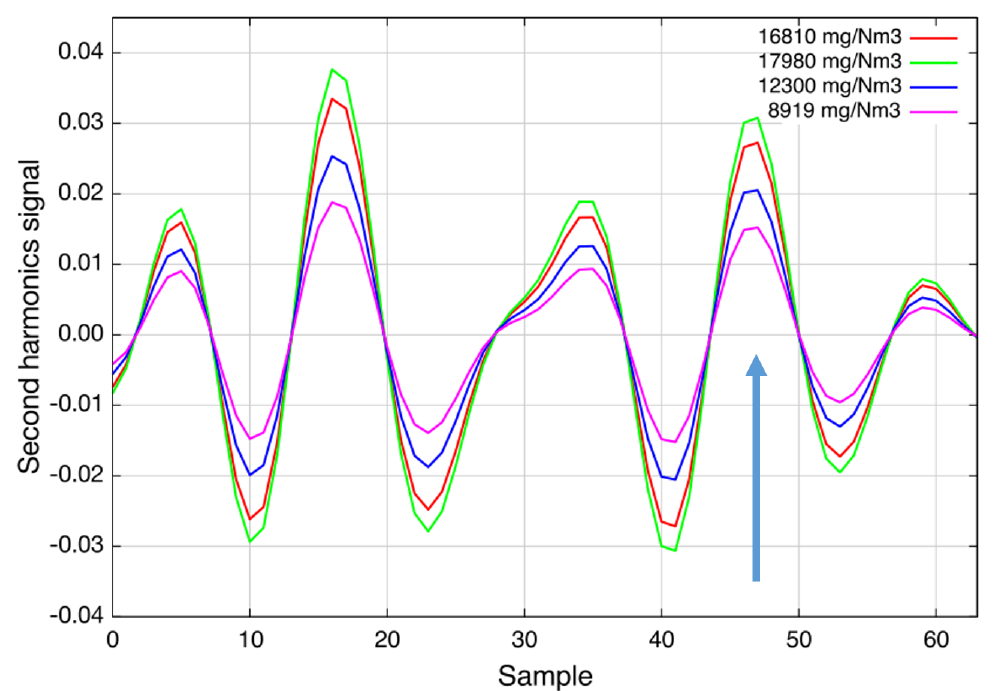
Figure 6. Second harmonic spectra of sulfur dioxide during a cleaning process of heavily-contaminated activated charcoal. This figure was previously used in the presentation of Geiser et al.